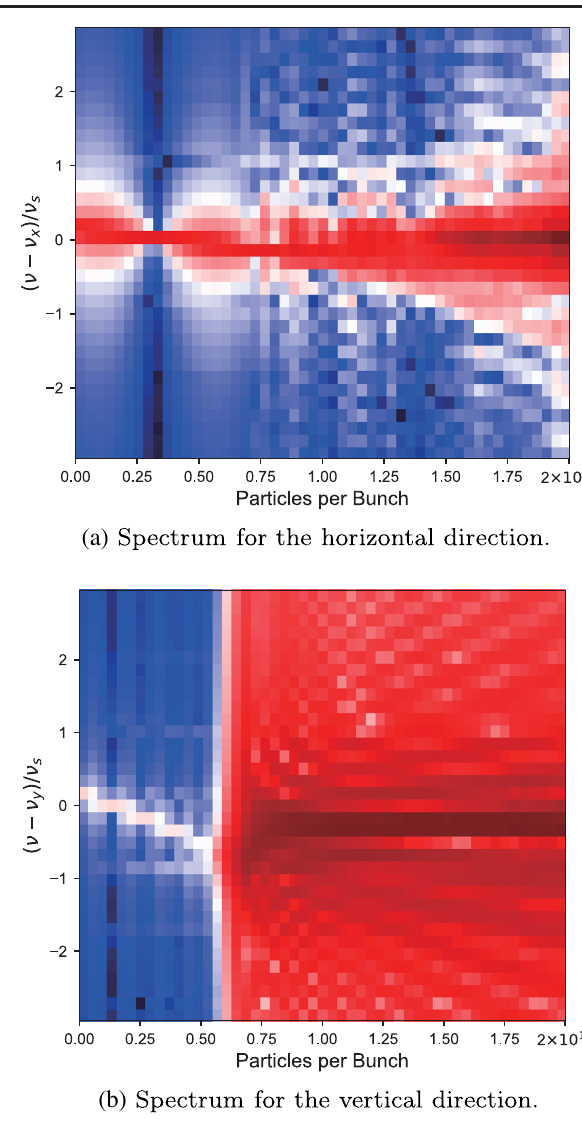
FIG. 5. The intensity is changed with a chosen step from a very small value 2 × 10 7 ppp to 2 × 10 12 ppp in 51 simulations. FFT algorithm is used to get the spectrum from the bunch displace- ment in every